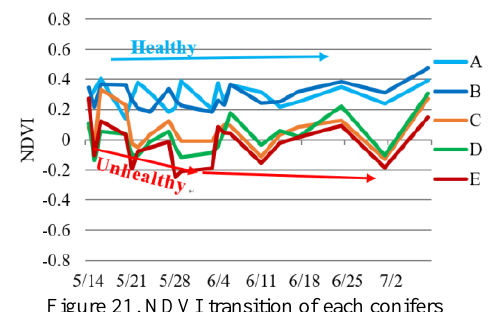
Figure 21. NDVI transition of each conifers